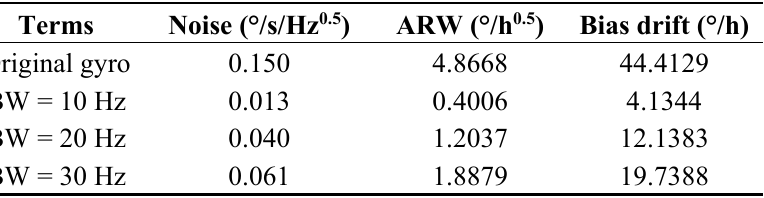
Table 2. Static test results of gyroscope noise by presented KF.